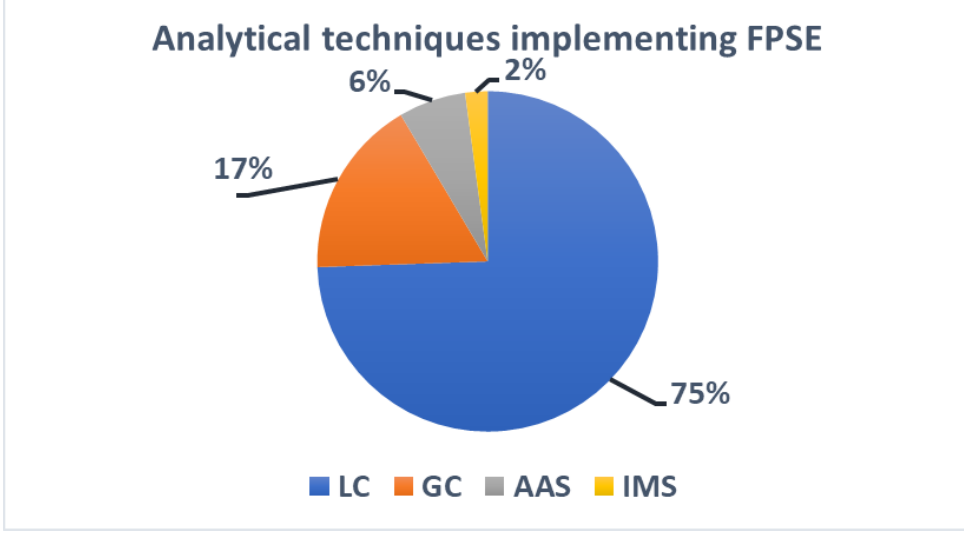
Figure 4. Graphical representation of different analytical instruments used (%) subsequent to FPSE.